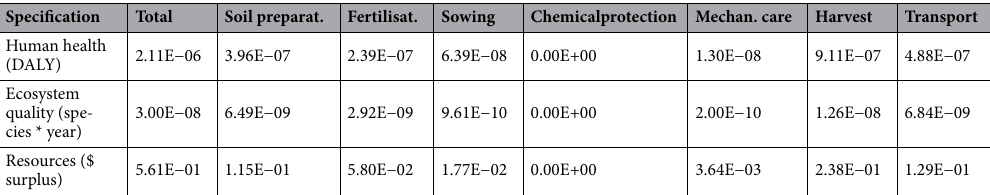
Table 3. Environmental impact related to the use of water in organic carrot production per area unit (ha).